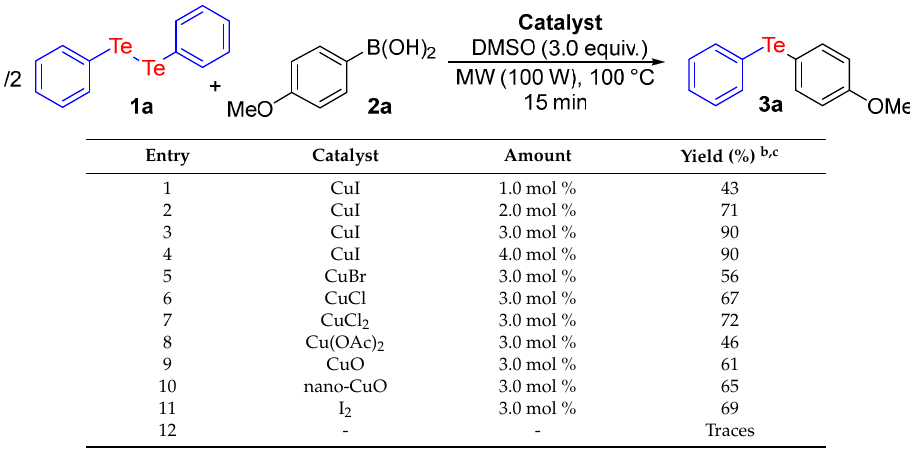
Table 1. Optimization of reaction conditions a .